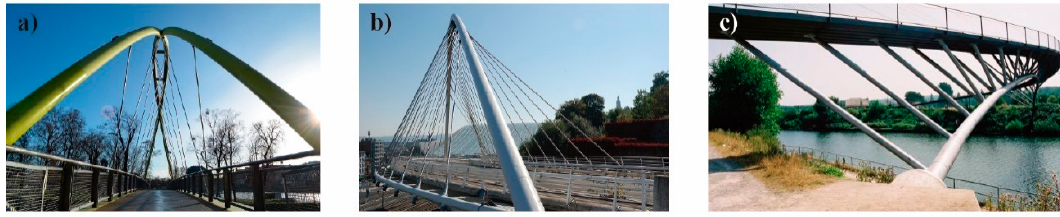
Figure 19. ( a ) Slodowa island Footbridge (photo, Metamorfa_Studio, pixabay.com (accessed on 17 December 2020)), ( b ) Pont de l’Observatoire (photo, Le Cointois, Wikimedia Commons), and ( c ) Ripshorst Footbridge (photo: Nicolas Janberg, structurae.net (accessed on 17 December 2020)).